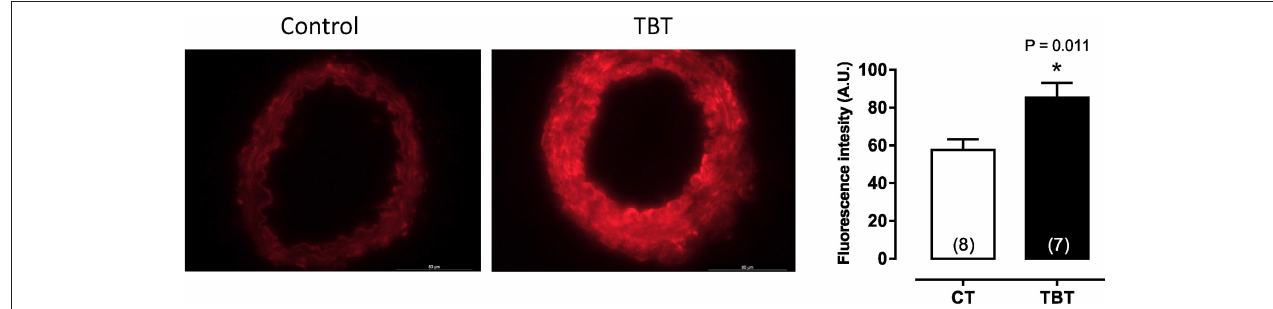
FIGURE 2 | Tributyltin increases vascular superoxide anion production in mesenteric arteries. Animals were treated with TBT (500 ng/Kg) for15 days. This figure is reprinted from Ribeiro Junior et al.